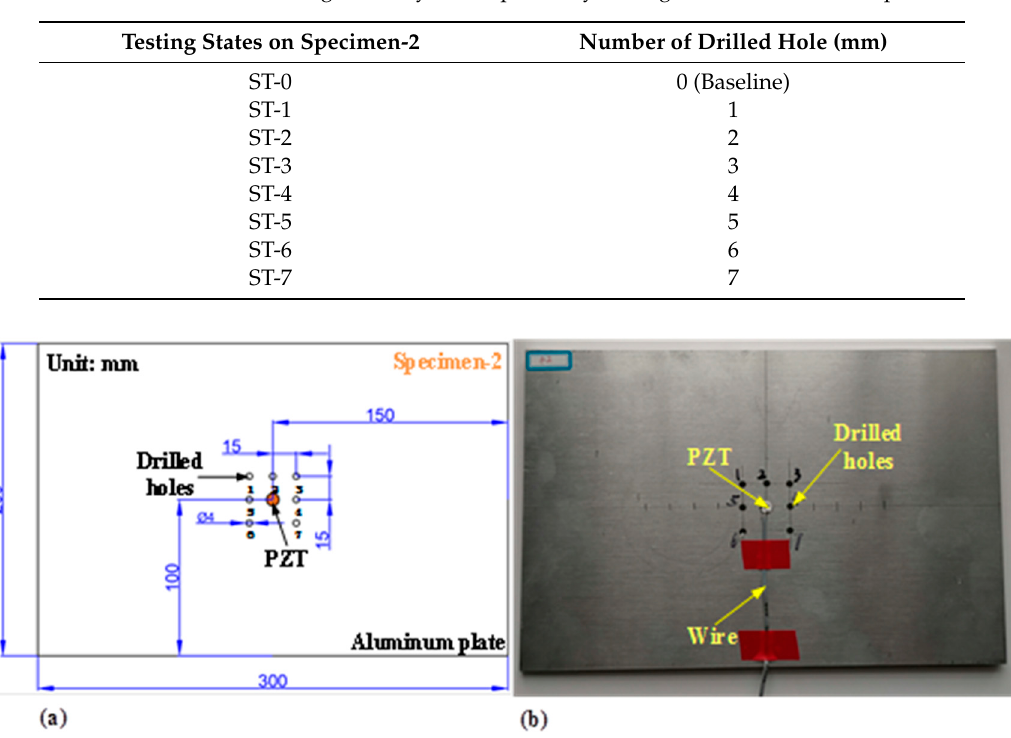
Figure 4. A part of real aircraft fuselage (specimen-3) used in experiment. Table 4. Simulated damage growth on the aircraft fuselage (specimen-3). Testing States on Fuselage Number of Drilled Hole (mm) ST-0